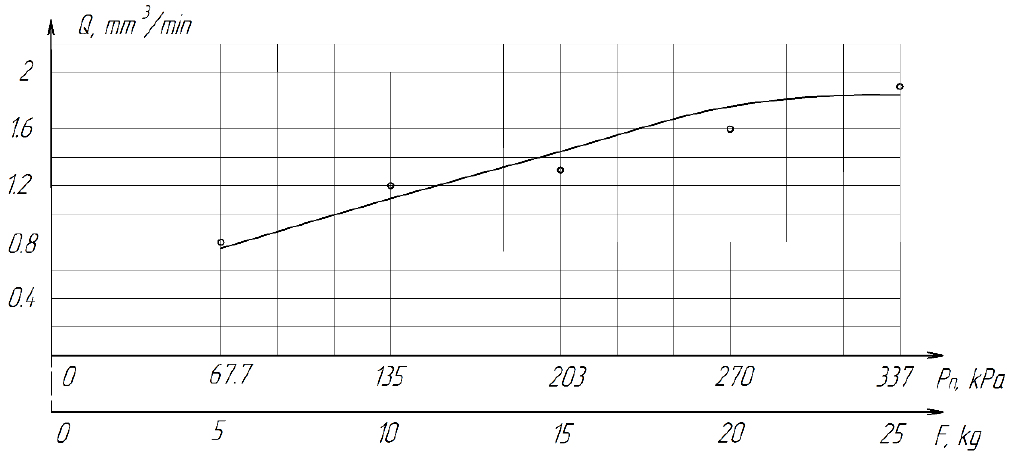
Figure 16. The effect of P n pressure on the processing performance of ZrO 2 ceramics.